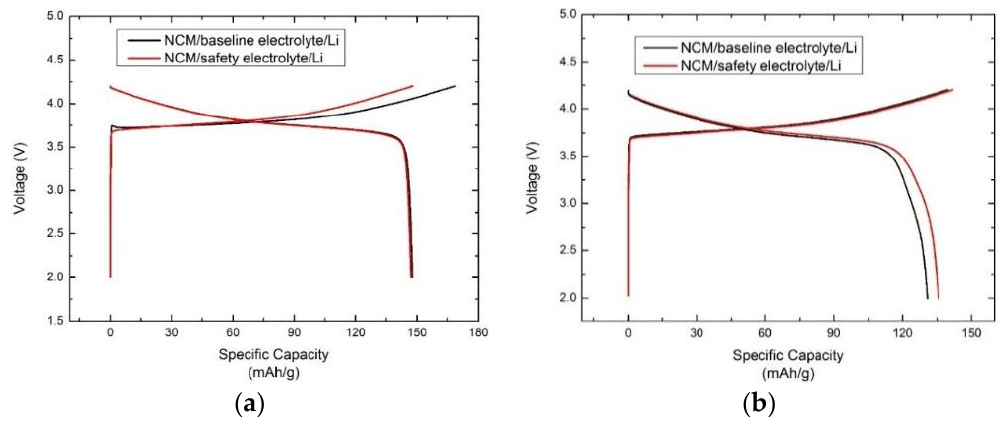
Figure 5. Charge/discharge plots of NCM/baseline electrolyte electrolyte/Li and NCM/safety electrolyte/Li half cells. The half cells were cycled between 2.0 V and 4.2 V at 0.1C: ( a ) 1st cycle; and ( b ) 65th cycle.